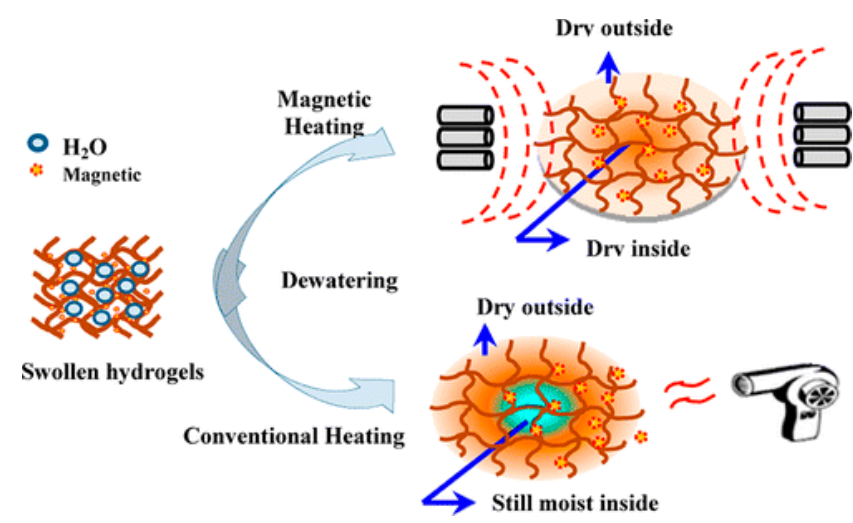
Figure 5. Schematic diagram of the effect of magnetic and conventional heating on the dewatering of nanocomposite polymer hydrogels being used as draw agents in the forward osmosis (FO) process. Reprinted from Reference [52] with permission from the ACS Journal.